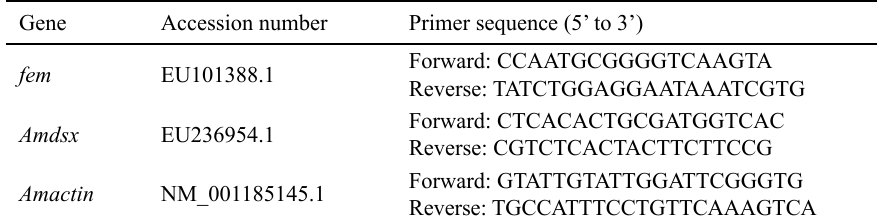
Table 1 . Primer sequences used for qRT- PCR